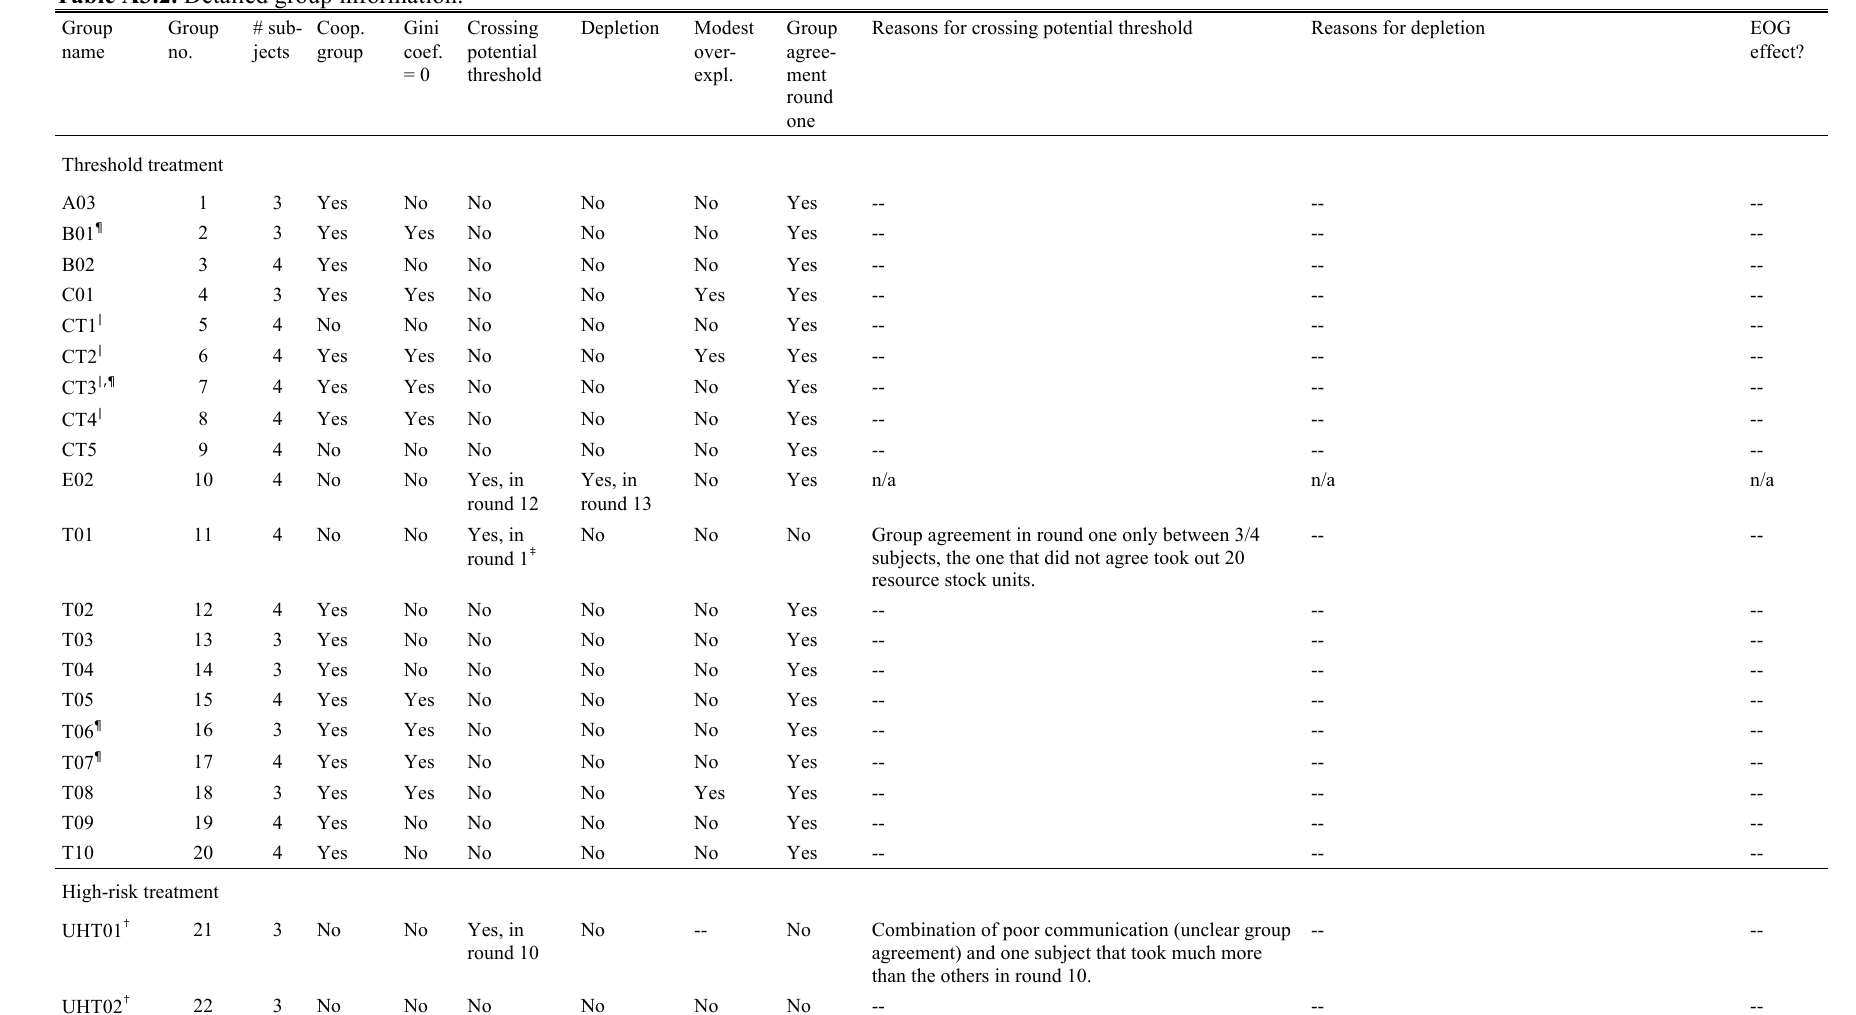
Table A3.2. Detailed group information. Group